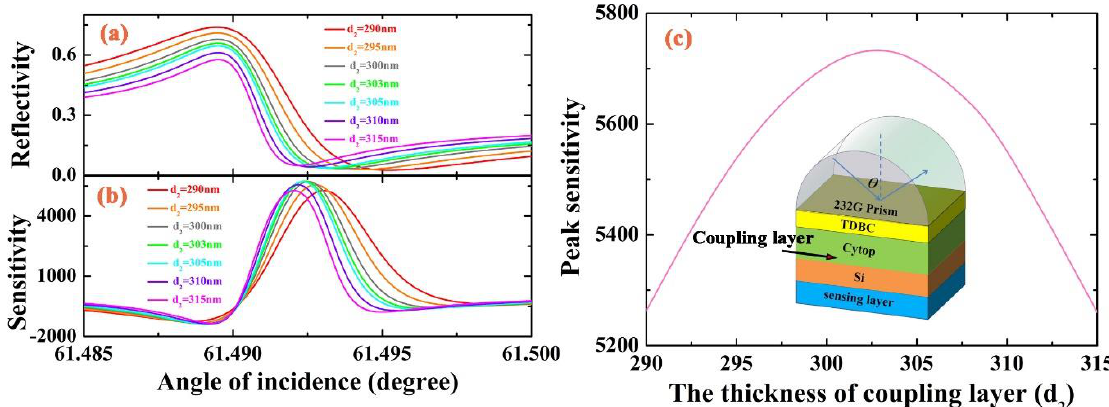
Figure 4. ( a – c ) Variation of reflection spectra, sensitivity and peak sensitivity with respect to the thickness of coupling layer (Cytop) d 2 ranging from 290 to 315 nm , where λ = 532 nm, d 1 = 35 nm, d 3 = 62 nm and n s = 1.327.